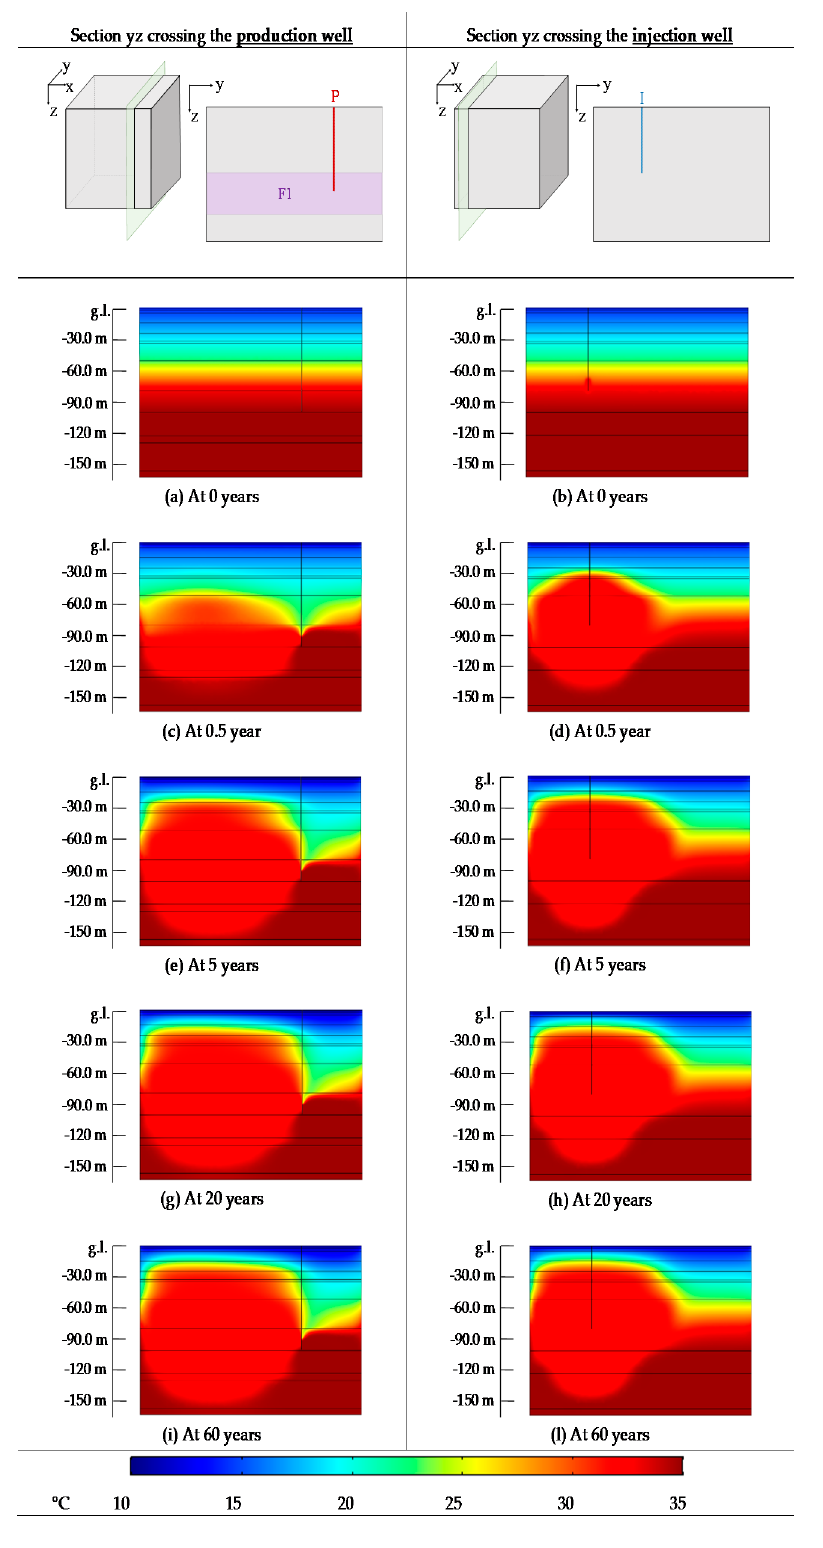
Figure 9. Temperature field of the sections yz crossing the wells, at different times, for Case 1 (single fault).